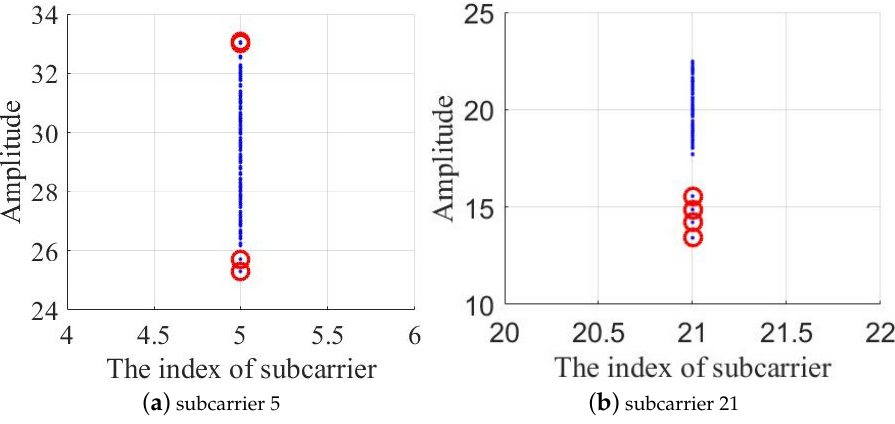
Figure 3. Anomaly detection based on LOF algorithm. The blue points represent the amplitude values of each subcarrier, and the point with a large degree of separation is marked with a red